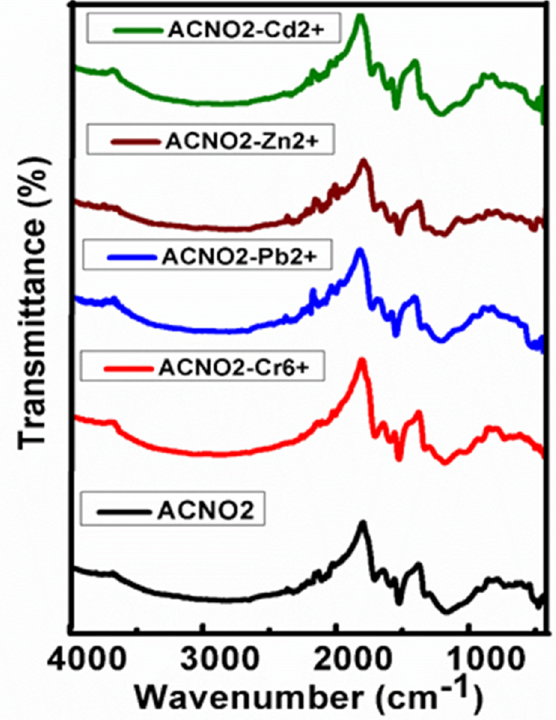
(Table 1) suggest the successful adsorption of the metal ions on the active sites of the FAC.